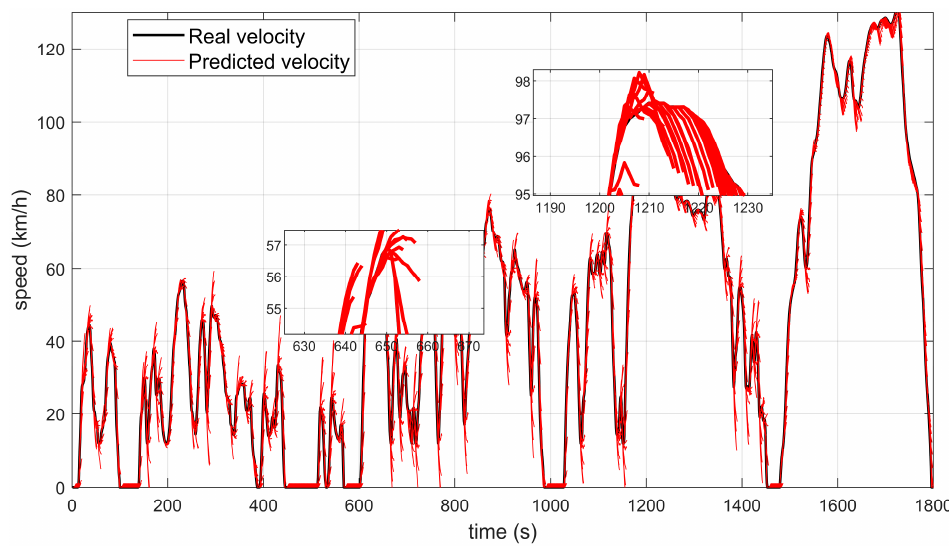
Table 3. Values of RMSE.